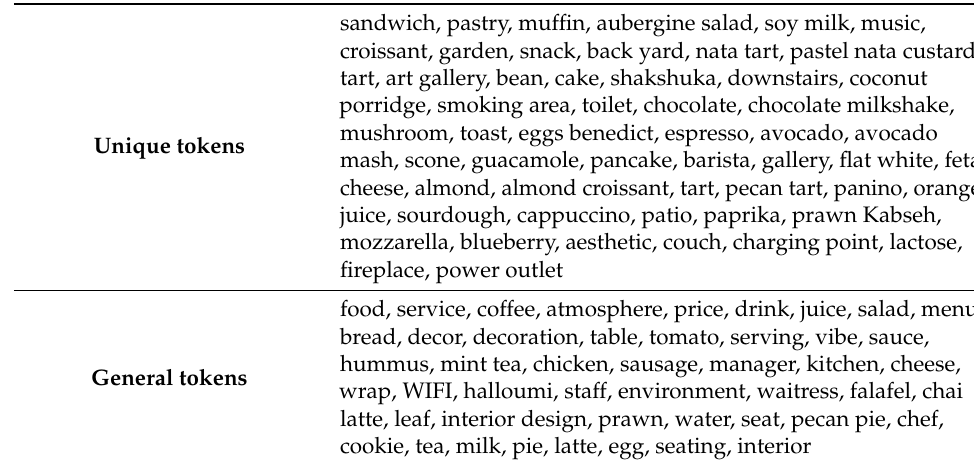
Table 3. Basic information on Mihbaj and its similar